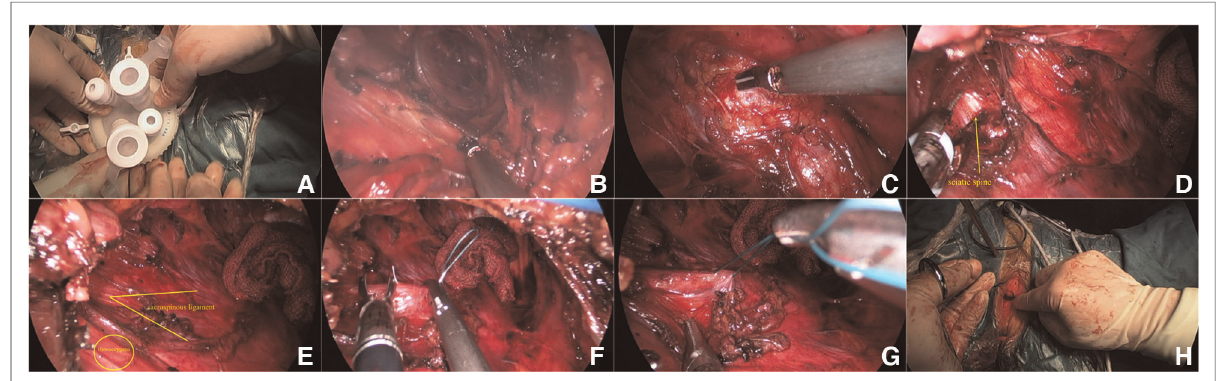
FIGURE 1 Surgical procedures. ( A ) Installing a specialized port for transvaginal single hole; ( B ) Separate tissue; ( C ) Expose the sacrospinous ligament at the sacrococcygeal attachment; ( D ) Expose the sciatic spine; ( E ) Expose the sacrospinous ligament and iliococcygeus; ( F ) Ethibond Excel W6937 non-absorbable suture to suture the sacral spine ligament; ( G ) Pull the suture to judge the tension; ( H ) Tie a knot with the